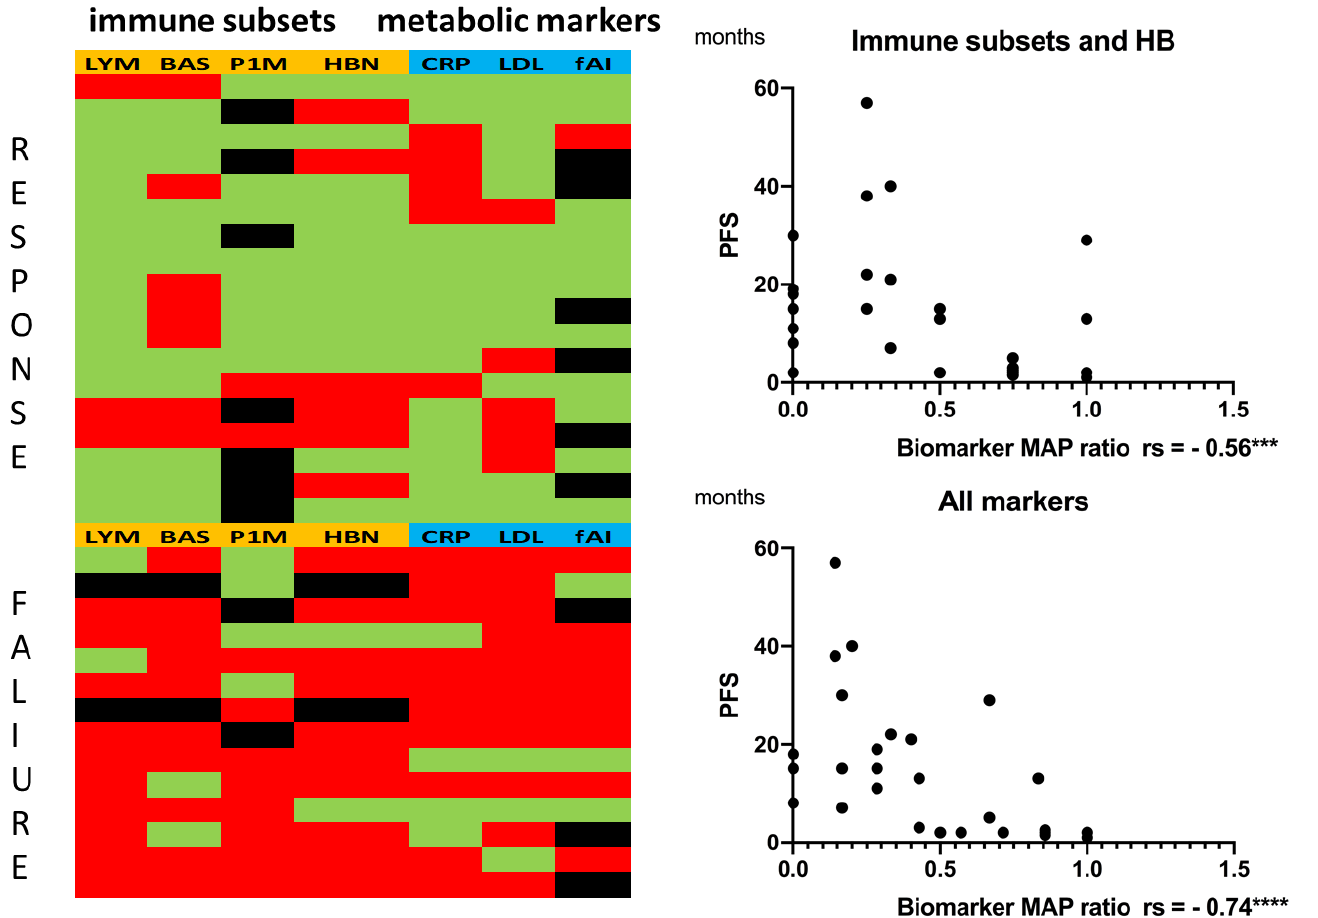
Figure 4. ( Left biomarker heatmap ) Immune subsets and hemoglobin (orange): LYM = absolute lymphocyte counts, BAS = absolute basophil counts, P1M = PD-1+ monocytes, HBN = hemoglobin. Metabolic markers (blue): CRP = C-reactive protein, LDL = low-density lipoprotein, fAI = free androgen index. Green: value within range, responder. Red: value within range, non-responder. Black: no data (fAI only for male patients: 8 patients were female). A ratio (biomarker map ratio) was formed by dividing the red fields by the total fields (green and red fields). ( Right ) Correlation between the biomarker map ratio and PFS: ( Top ) immune subsets only (with hemoglobin). ( Bottom ) immune subsets combined with metabolic markers. Statistics are reported in Supplemental Data S5 and S6. Significance was indicated as *** p < 0.001 and **** p < 0.0001.